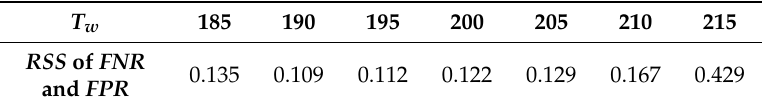
Table 3. Root sum square of FNR and FPR when T w varied from 185 to 215.